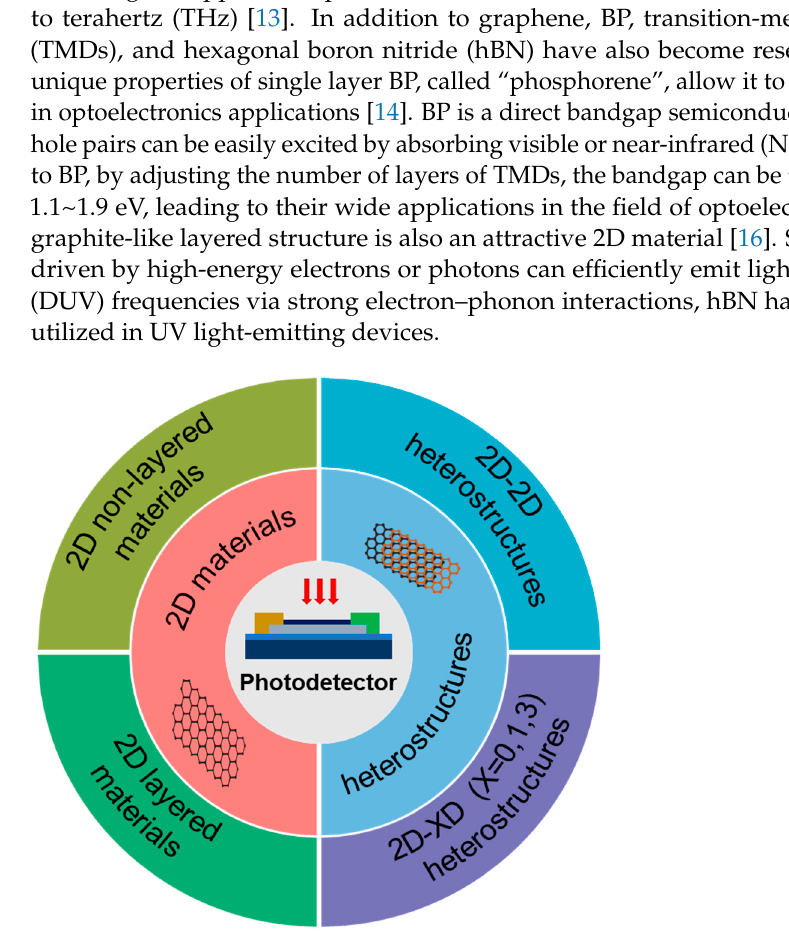
Figure 1. The research focus of 2D materials for PDs, including 2D nonlayered materials, 2D layered materials, and their heterostructures.